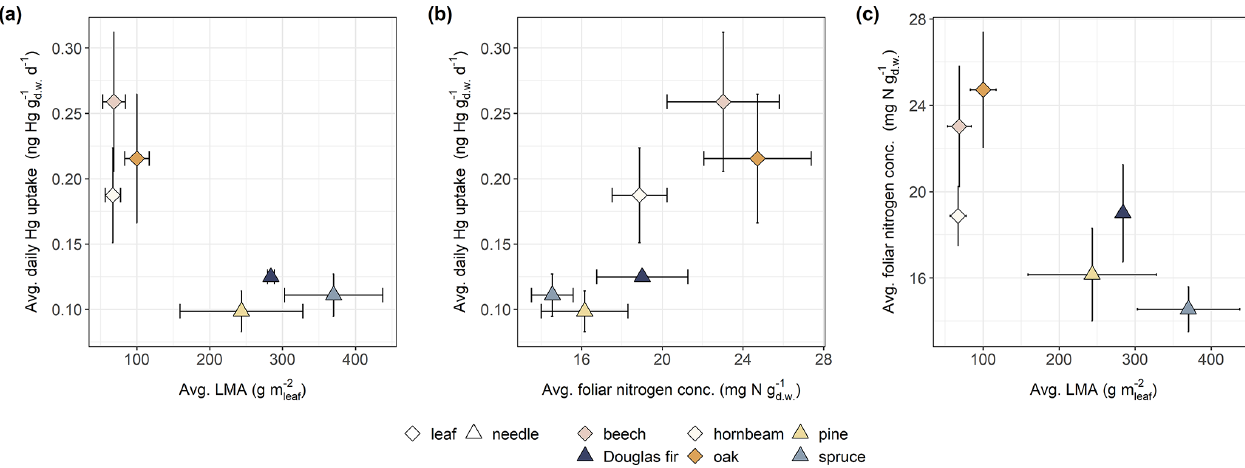
Figure 4. (a) Average daily Hg uptake rates (ngHgg − 1 d − 1 ), (b) average foliar nitrogen concentrations (mgNg − 1 d.w. LMA (g d.w. m − 2 ) determined in 349 foliage samples and resolved by tree species group and foliage type (leaf/needle). Error bars denote leaf ± 1 standard deviation. Number of samples ( n ) differs between tree species: beech ( n = 164), Douglas fir ( n = 2), hornbeam ( n = 9), oak ( n = 106), pine ( n = 35), and spruce ( n = 33).